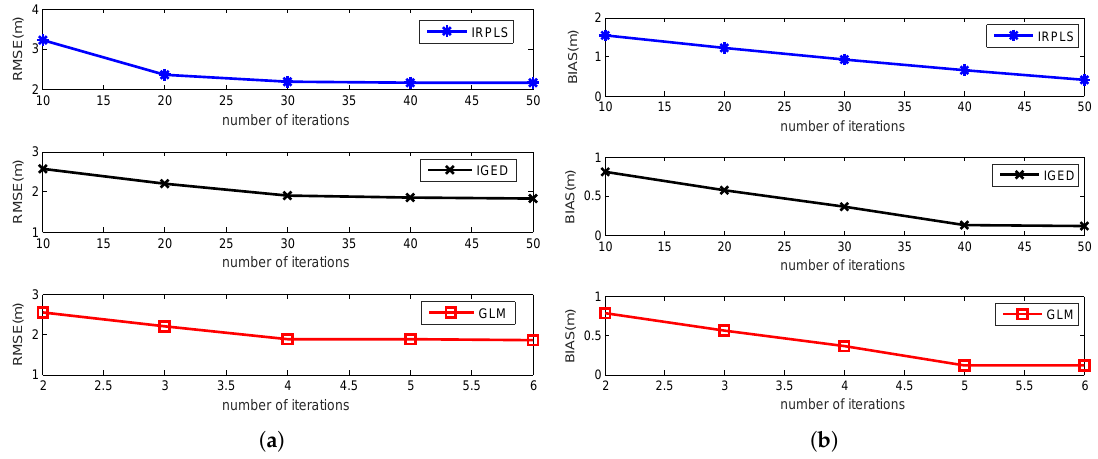
Figure 10. RMSE and bias performance versus the number of iterations for IRPLS, IGED and GLM. ( a ) RMSE results. ( b ) Bias norm